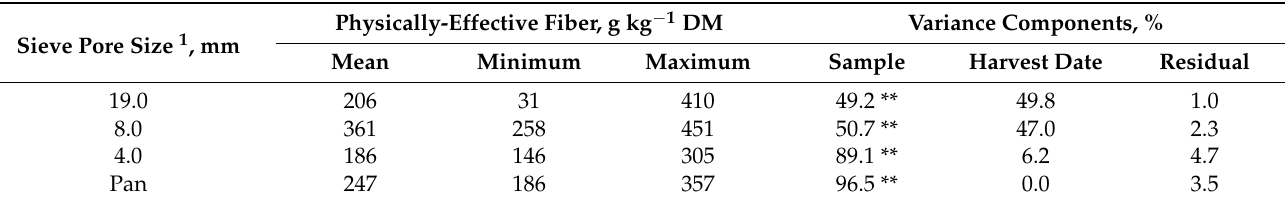
Table 2. Particle size distribution of dried paunch manure obtained from cattle harvested at the Tarleton Meats Laboratory, Stephenville, TX,